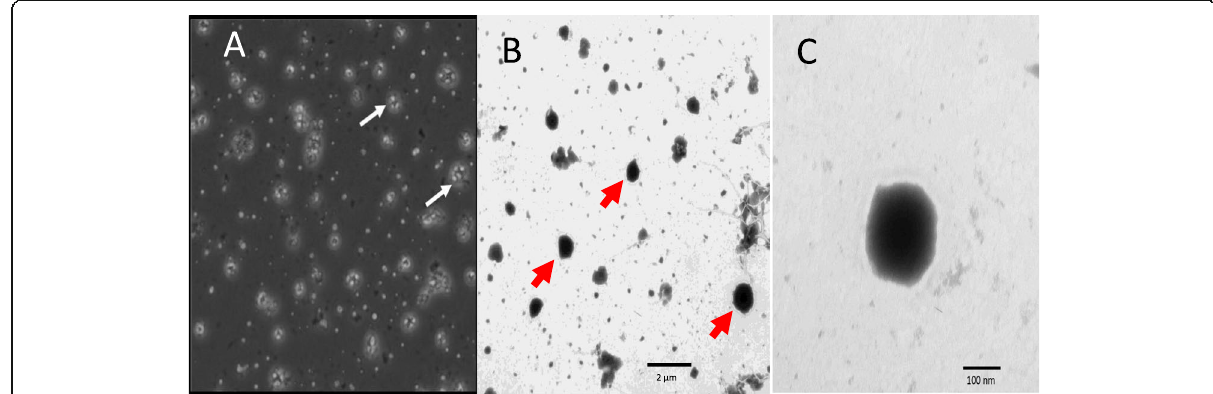
Fig. 1 Electron micrographs of Spodoptera littoralis SpliMNPV-Cab3 OBs. a Light microscope examination showing the SpliNPV-Cab3 occlusion bodies. b Transmission electron micrograph showing the SpliNPV-Cab3 occlusion bodies as indicated by red arrows. Bar = 2 μ m. c Viral occlusion body showing typical NPV polyhedral shape. Bar = 100 nm